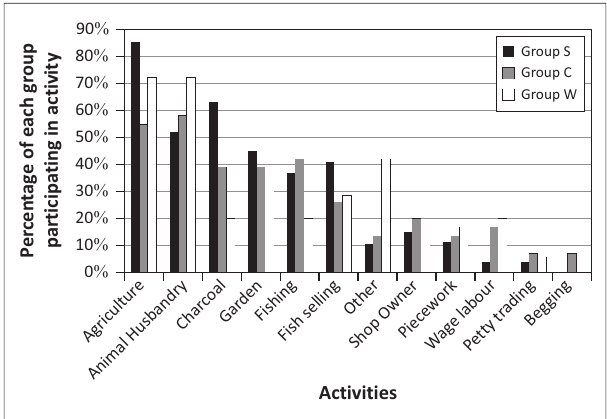
FIGURE 11: The different patterns of livelihoods activity for the three groups in Kasaya.